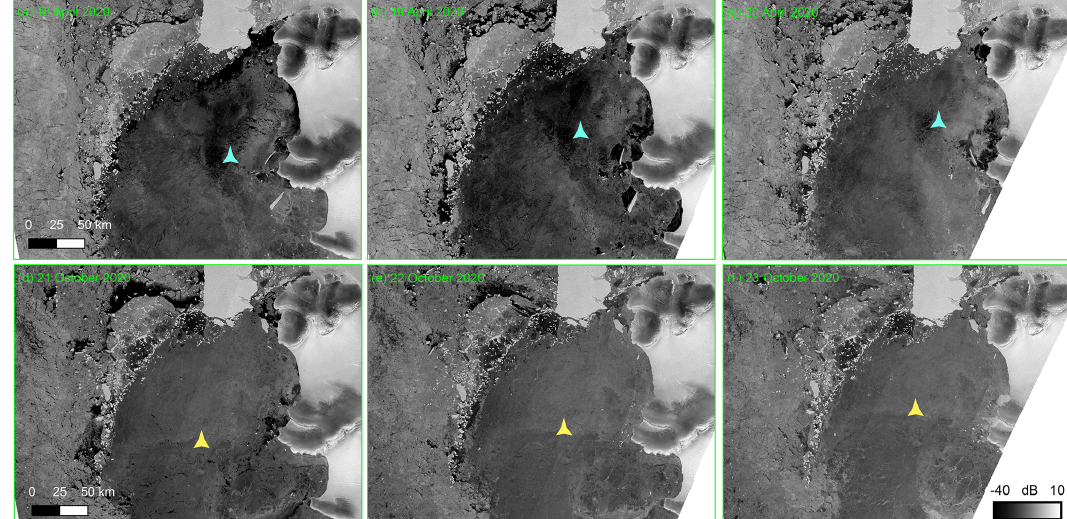
Figure 3. Examples of backfilling ice earlier produced by the ASP flowing back towards the area adjacent to the Iceberg Chain where it formed. Each box corresponds to the same area shown by the dashed green box in Fig. 2a; panels (a) – (c) show the area on 18–20 April 2020; panels (d) – (f) show 21–23 October 2020. The colored shapes in each image are in approximately the same relative position within the ice in each set of images and are to help the reader spot the movement of the ice through the movement of adjacent features. Other examples of backfilling are visible in Video S1.